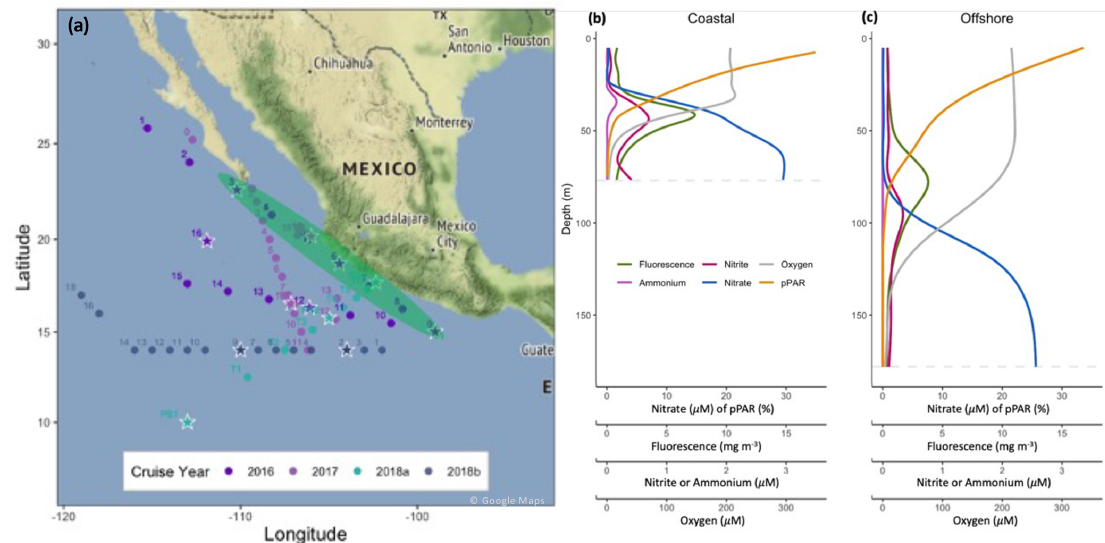
Figure 1. Map of the ETNP region showing stations included in this study from four cruises between 2016–2018 (a) . Stations where rate measurements were made are marked with white stars. Pump profile data were collected at each station occupied during the 2016 cruise, and coastal stations are encircled in green. Mean water column profiles from example “coastal” stations (8 and 9) and example “offshore” stations (14 and 16) during the 2016 cruise (b, c) . Dashed grey line depicts the depth at which dissolved oxygen concentrations declined below